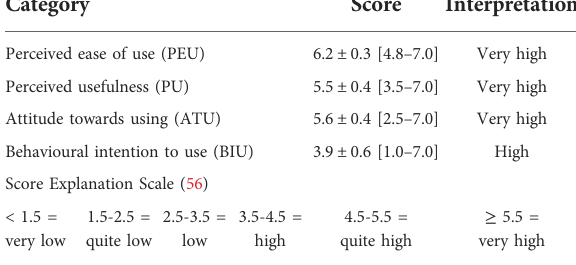
TABLE 3 Acceptance of “ Fit ” as analysed with the technology acceptance model questionnaire (values represent mean±SD of the given